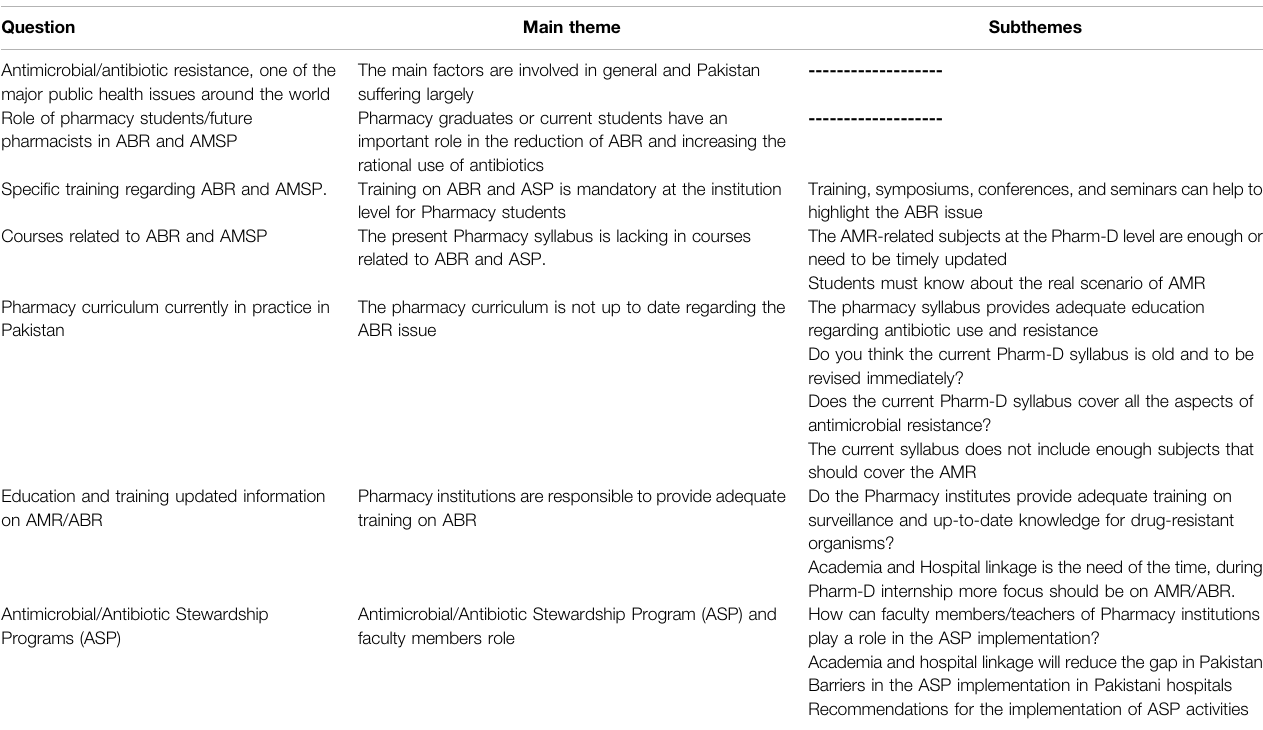
TABLE 7 | Detailed summary of themes, sub-themes, and questions for faculty members